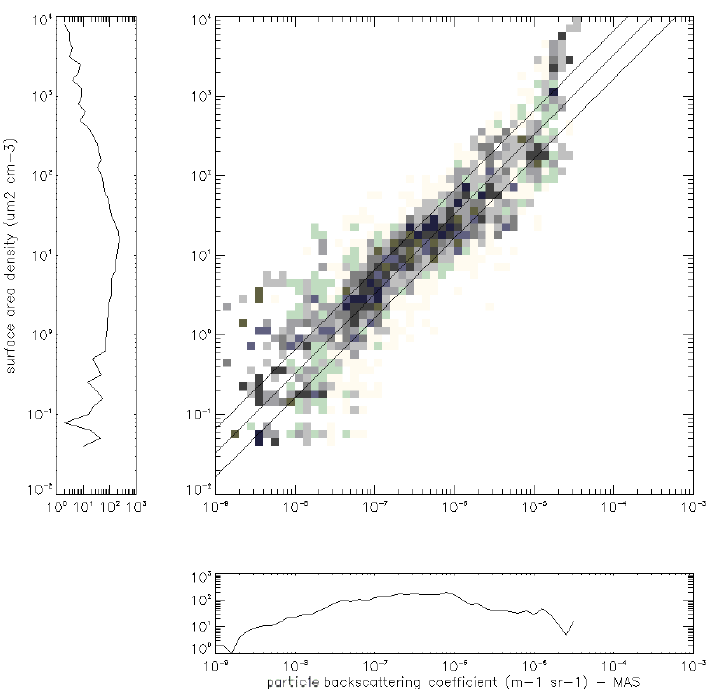
Fig. 7. Observation frequency histogram for β measured by the backscattersonde (horizontal, below) and for the particle surface area density S (vertical, on the left). The central panel shows, in arbitrary units color coded in gray scale, the joint probability density distribution for the two quantities. A linear fit with the parameters reported in Table 2, together with a region wheere the mismatch is below a factor 2, is also displayed.